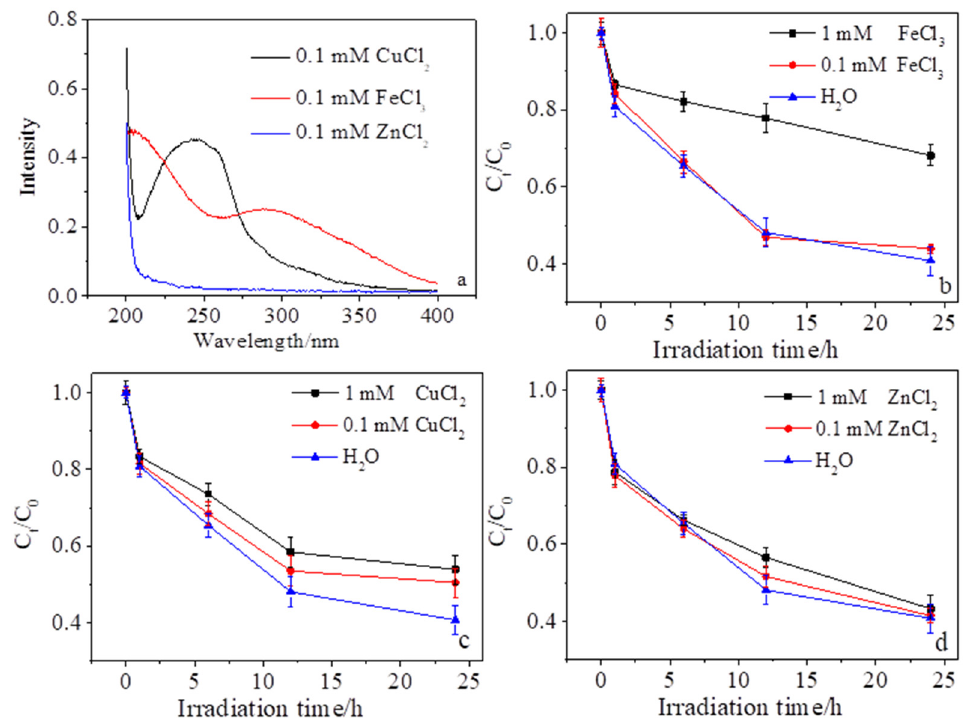
Figure 3. ( a ) UV absorption spectrum of 0.1 mM FeCl 3 , CuCl 2 and ZnCl 2 solution; BDE-209 photodegradation in soil suspensions with different FeCl 3 ( b ), CuCl 2 ( c ) and ZnCl 2 ( d ) solutions. Table 6. BDE-209 photodegradation kinetic parameters with different metal ions solutions.